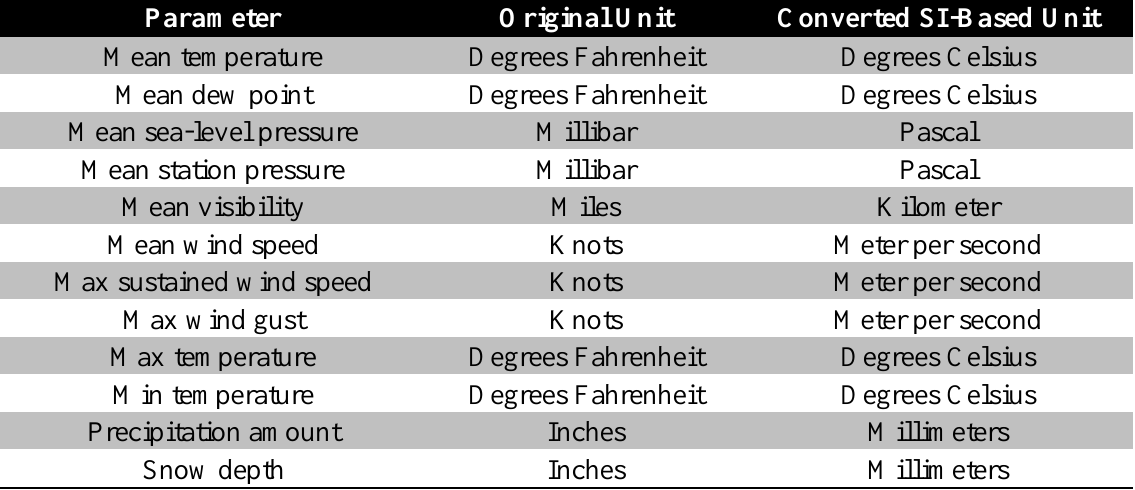
Table 3. Available climate parameters within the dataset (original and converted units). SI, International System of Units.